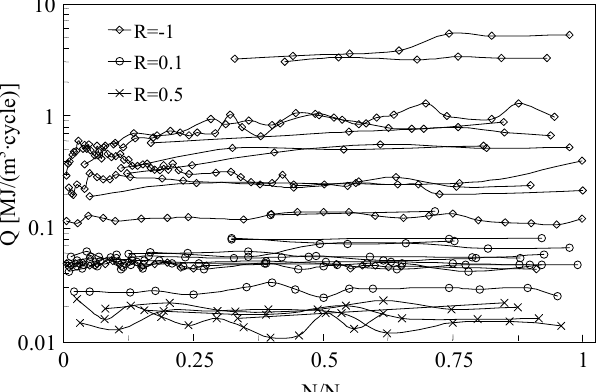
Figure 5: Measured Q trends against the number of cycles normalised with respect to the number of cycles to failure, N f .